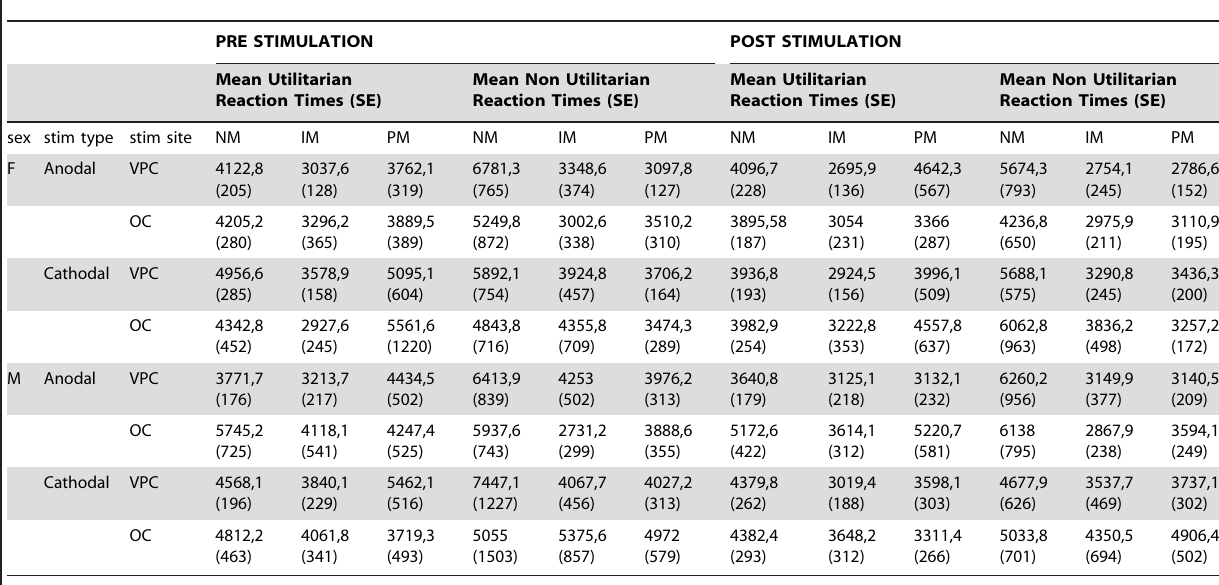
Table 2. Mean utilitarian and non-utilitarian reaction times pre and post